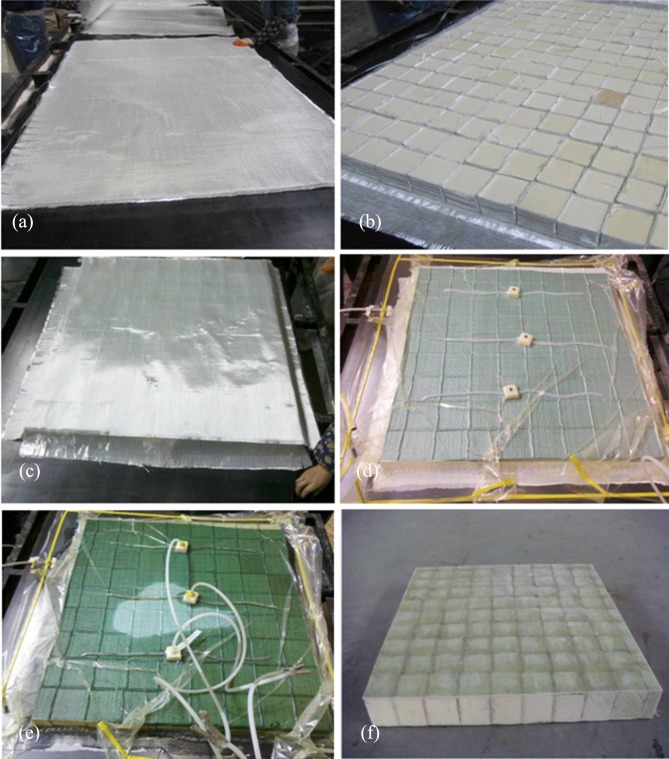
Process of sandwich panel preparation.(a) Laying of the lower layer of fiber cloth. (b) Laying of the core material. (c) Laying of the upper face sheet of fiber cloth. (d) Laying of the vacuum bag. (e) Resin infusion. (f) Cutting and shaping.